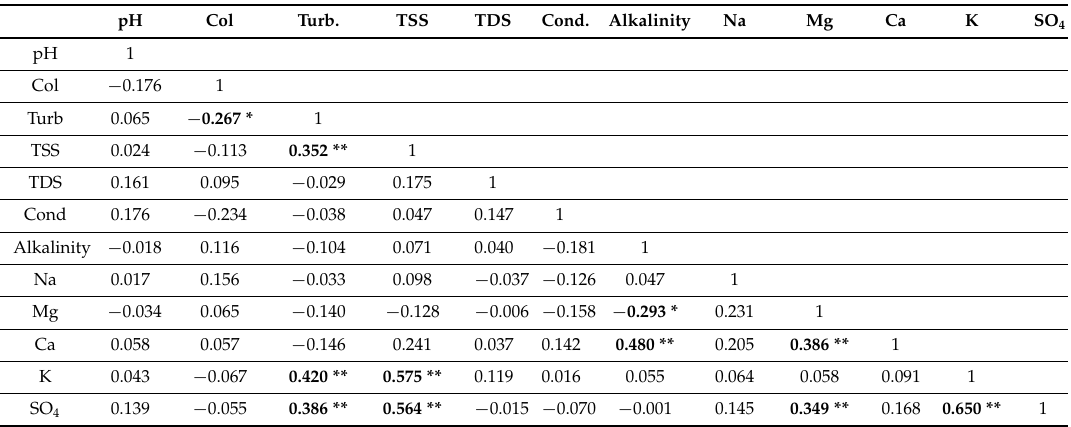
Table 4. Pearson’s Product-Moment Correlation Coefficients for major ions in water samples from the study area.